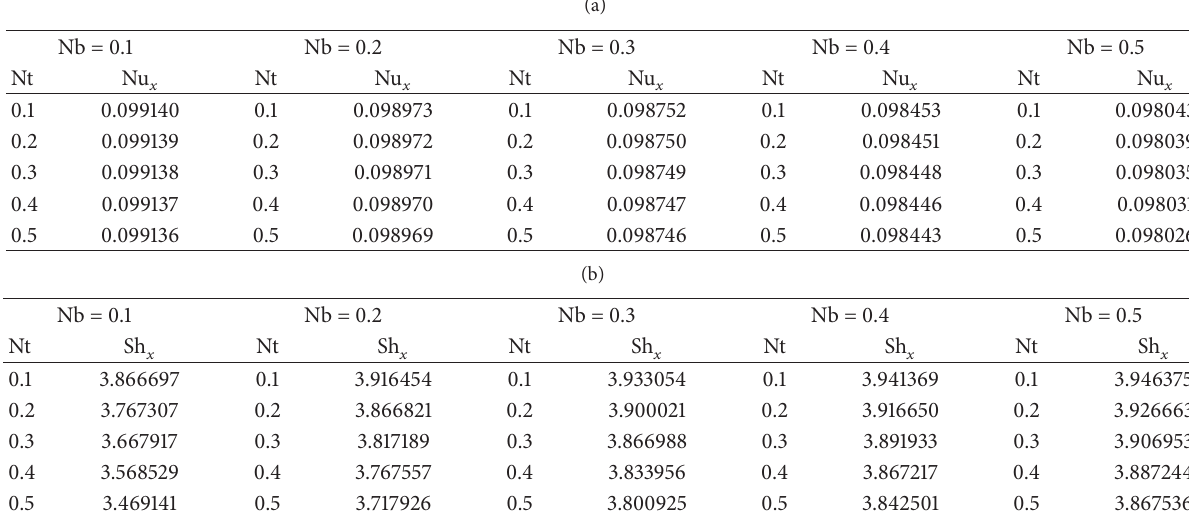
Table 2: (a) Variation of the local Nusselt number Nu 𝑥 with Nb and Nt and (b) variation of the local Sherwood number Sh 𝑥 with Nb and Nt for 𝛾 = 0.1, Le = 2, and Pr = 6.8.